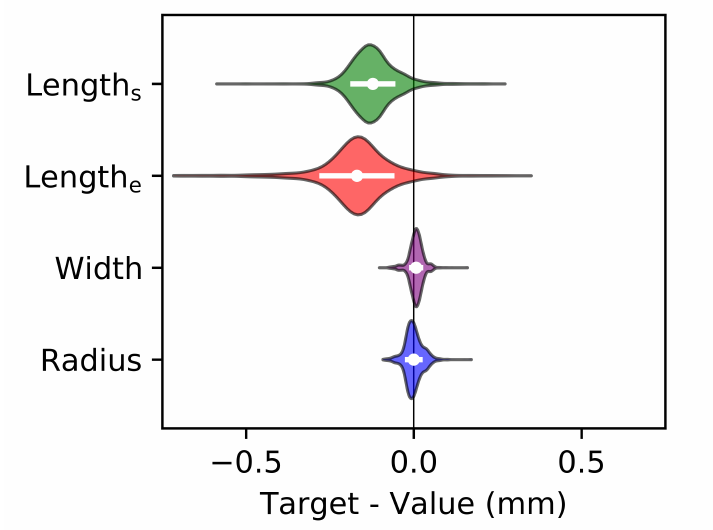
Figure A5. Violin Plots of measured arm length, width, and spiral center radius. The thickness of each violin depicts the probability density of printing a spiral of that value. The white dots indicate the mean while the bars indicate standard deviation. Each parameter is normalized to the target value ( x = 0).